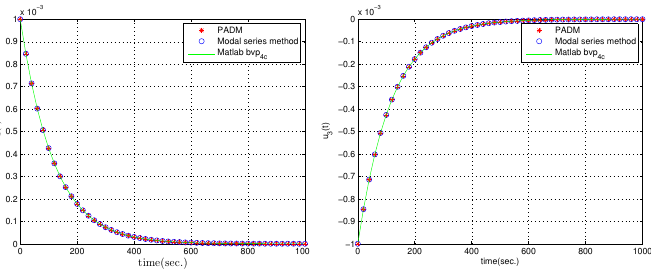
Figure 4. Comparison the bvp4c , modal series method and PADM ( m = 2, M = 50) approximate solution of x 2 ( t ), u 2 ( t ).